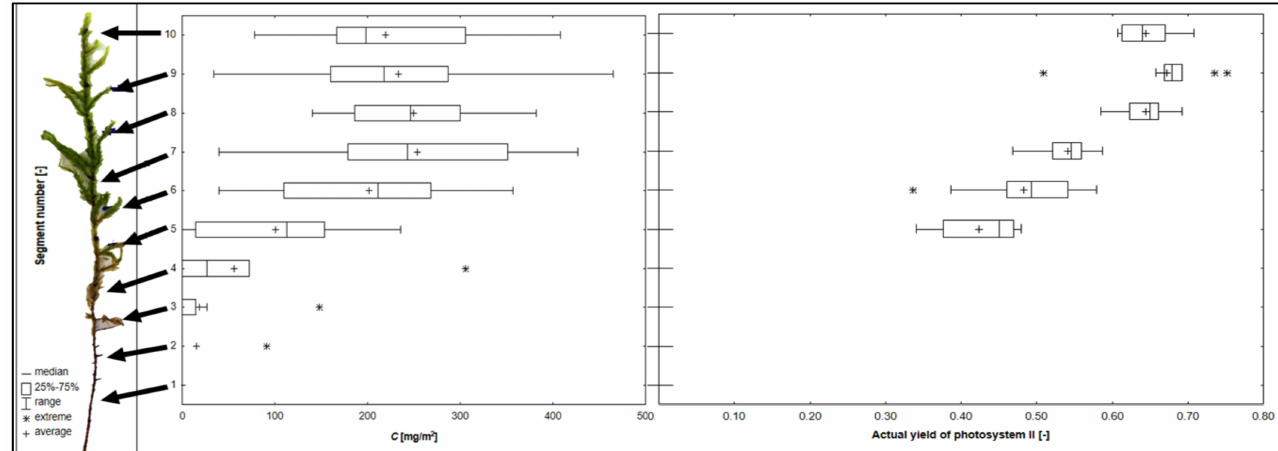
Figure 1. Changes in the chlorophyll content and actual yield of photosystem II in the vertical profile of moss gametophyte.